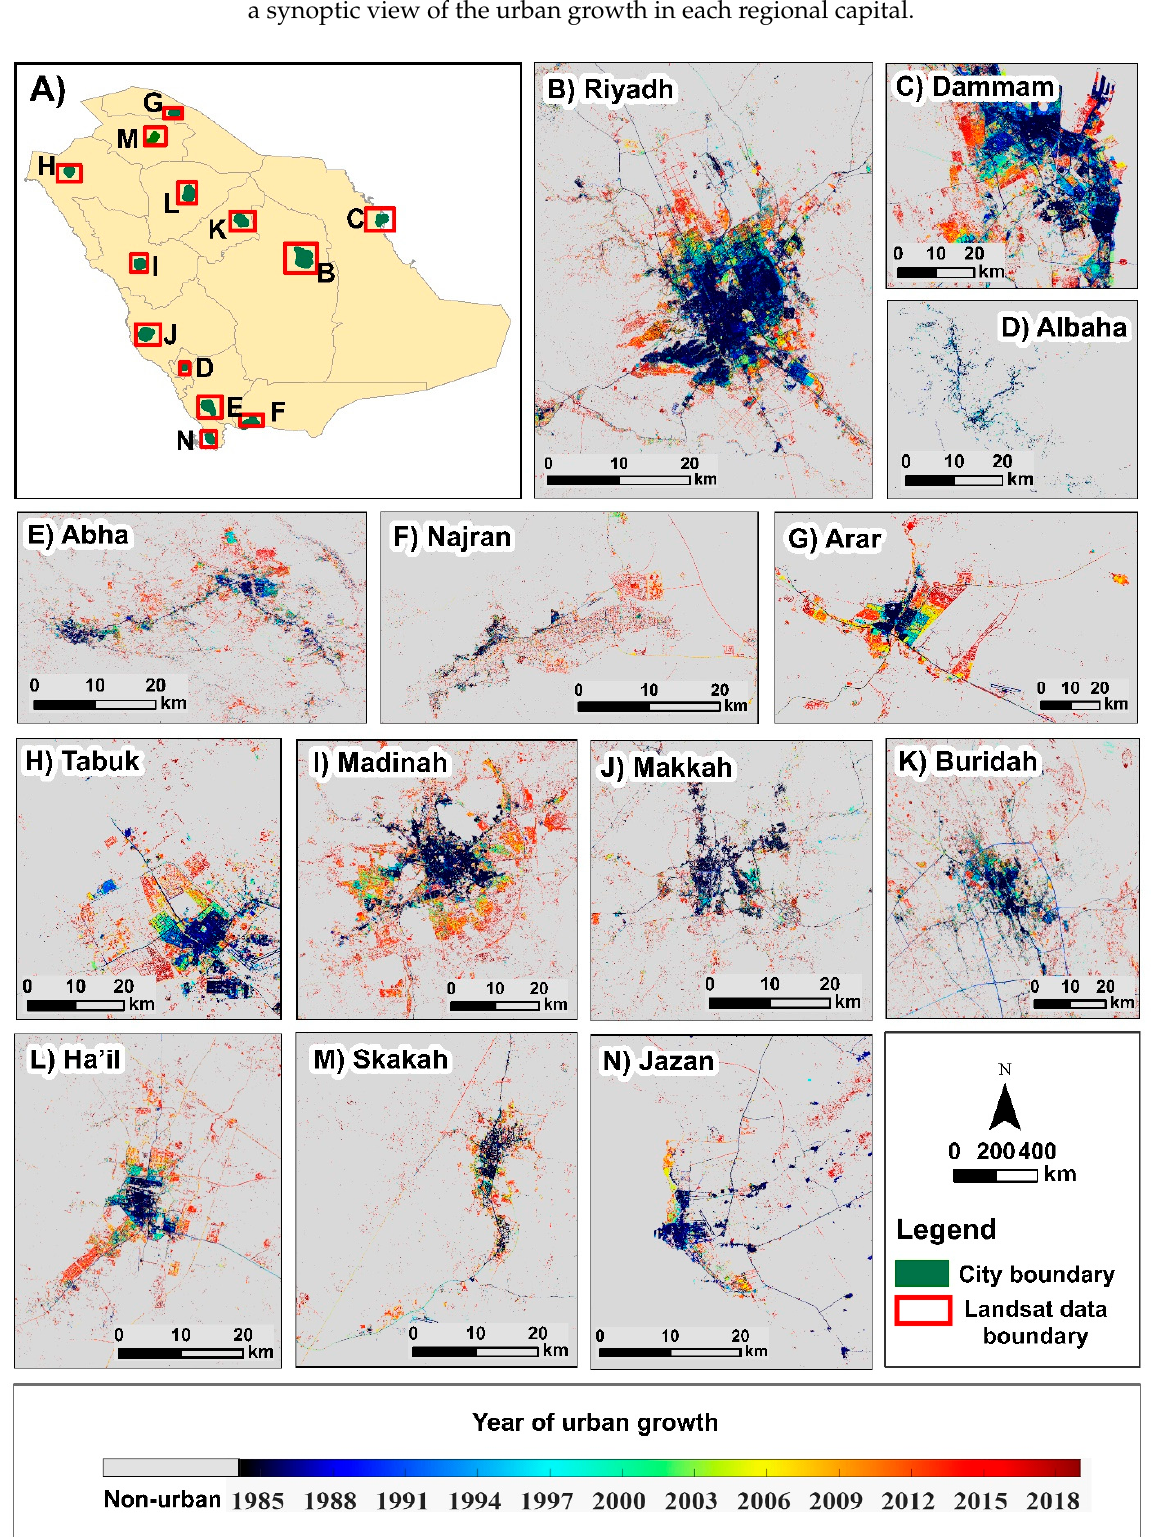
Figure 9. A map of Saudi Arabia ( A ) and multi-temporal urban change maps for all 13 capitals ( B – N ).